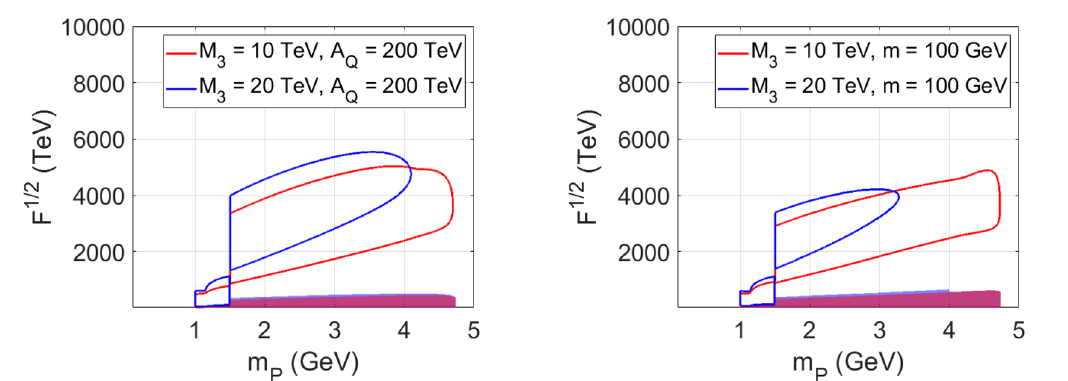
Figure 30 . FASER-II sensitivity to light pseudoscalar sgoldstinos produced in B-meson decays via flavor-conserving couplings (left panel) and flavor-violating couplings with A Q = 100 GeV(right panel). Sgoldstino decays into a gluon pair inside the detector volume. Shaded areas correspond to √ √ restrictions from table 1. In the regions where F < M 3 we set M 3 = F and similarly for A Q